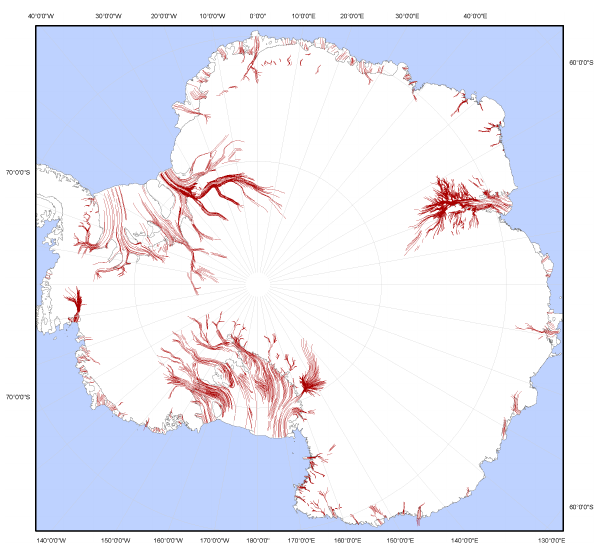
Figure 1. Continent-wide distribution of longitudinal ice-surface structures on the Antarctic Ice Sheet. The map is compiled from ca. 3600 individual longitudinal ice-surface structures. Antarctic Penin- sula glaciers and ice shelves already mapped by Glasser and Scam- bos (2008) and Glasser et al. (2009) are not included.